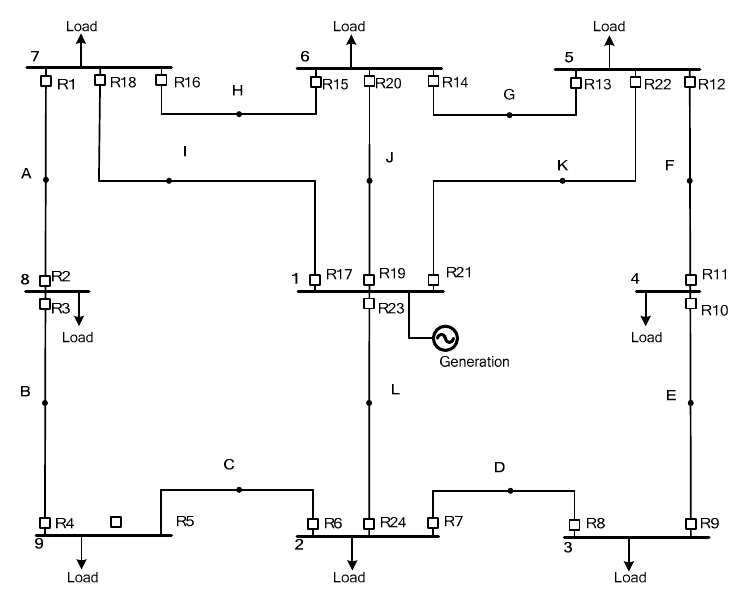
Figure 12. Single line diagram of the IEEE 9-bus system.